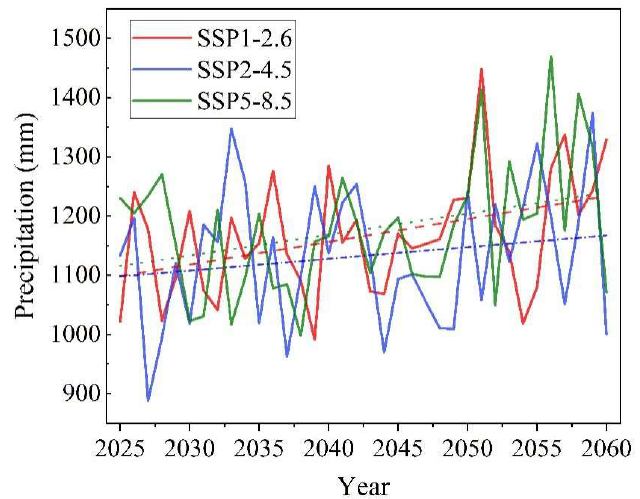
Figure 9. The variation of the precipitation at annual scale in the future period of 2025–2060.